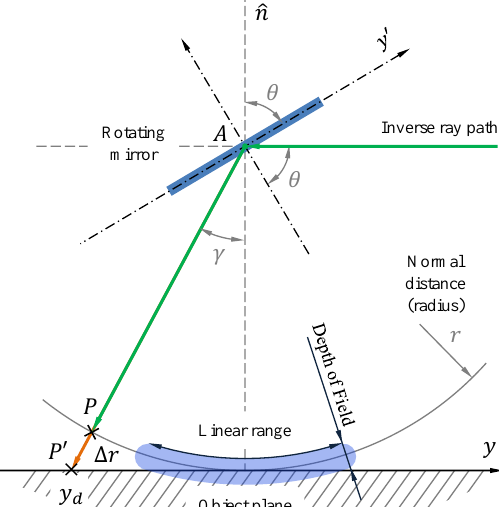
Figure 3. Rotating mirror geometry and linear range of operation. An image is acquired by varying rotating mirror angle θ . The optical path is increased by ∆ r ( θ ) , which produces distortion and defocusing. These artifacts can be considered negligible for an angle interval Θ (linear